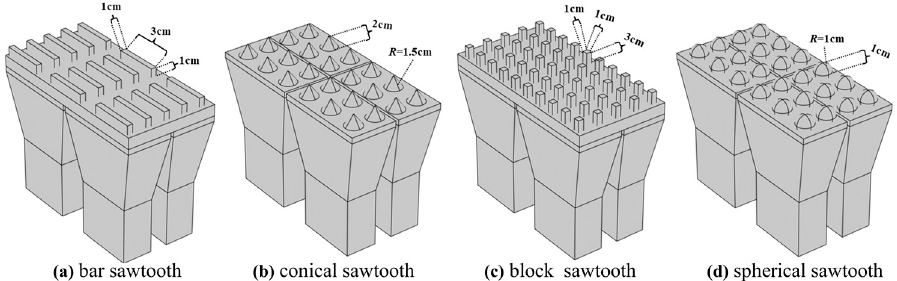
Figure 11. Sawtooth structure design solutions. ( a ) bar sawtooth ( b ) conical sawtooth ( c ) block sawtooth ( d ) spherical sawtooth.